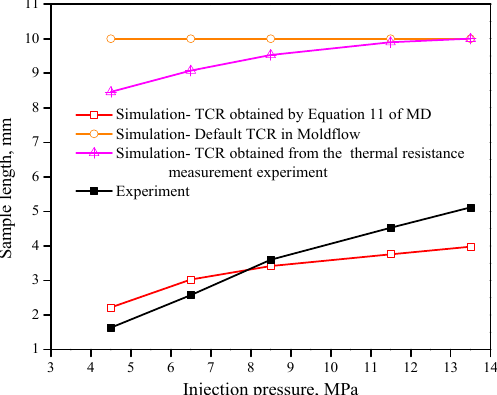
Figure 14. Injection sample length under different interface thermal resistance values and injection pressures.